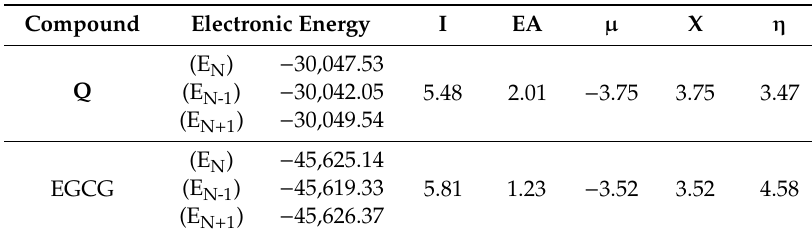
Table 2. Chemical reactivity parameters and total electronic energy of quercetin (Q) and epigallocatechin gallate (EGCG) calculated with B3LYP / 6-31G (d,p) in solvent phase. For the reactivity calculation parameters see Equations (1)–(5). All the values are in